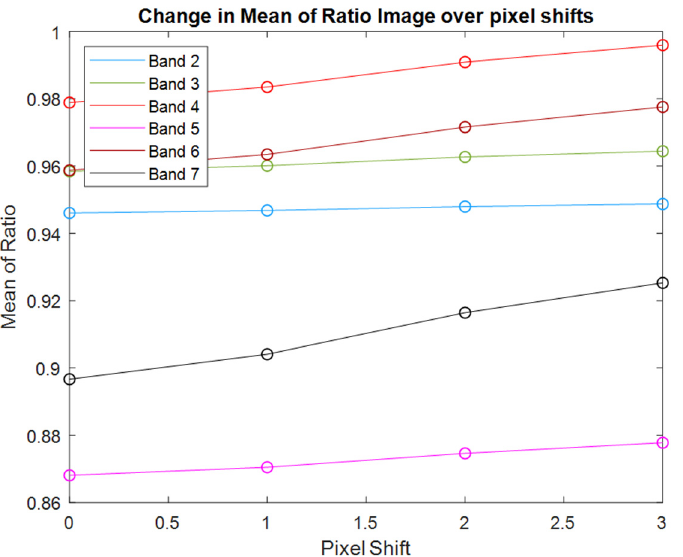
Figure 3. Change in cross-calibration ratio as a function of point error. These data were extracted from archived Landsat 7/8 underfly imagery and include the effects of SBAF to minimize spectral error. Thus, changes due to only pointing error will be smaller than values indicated